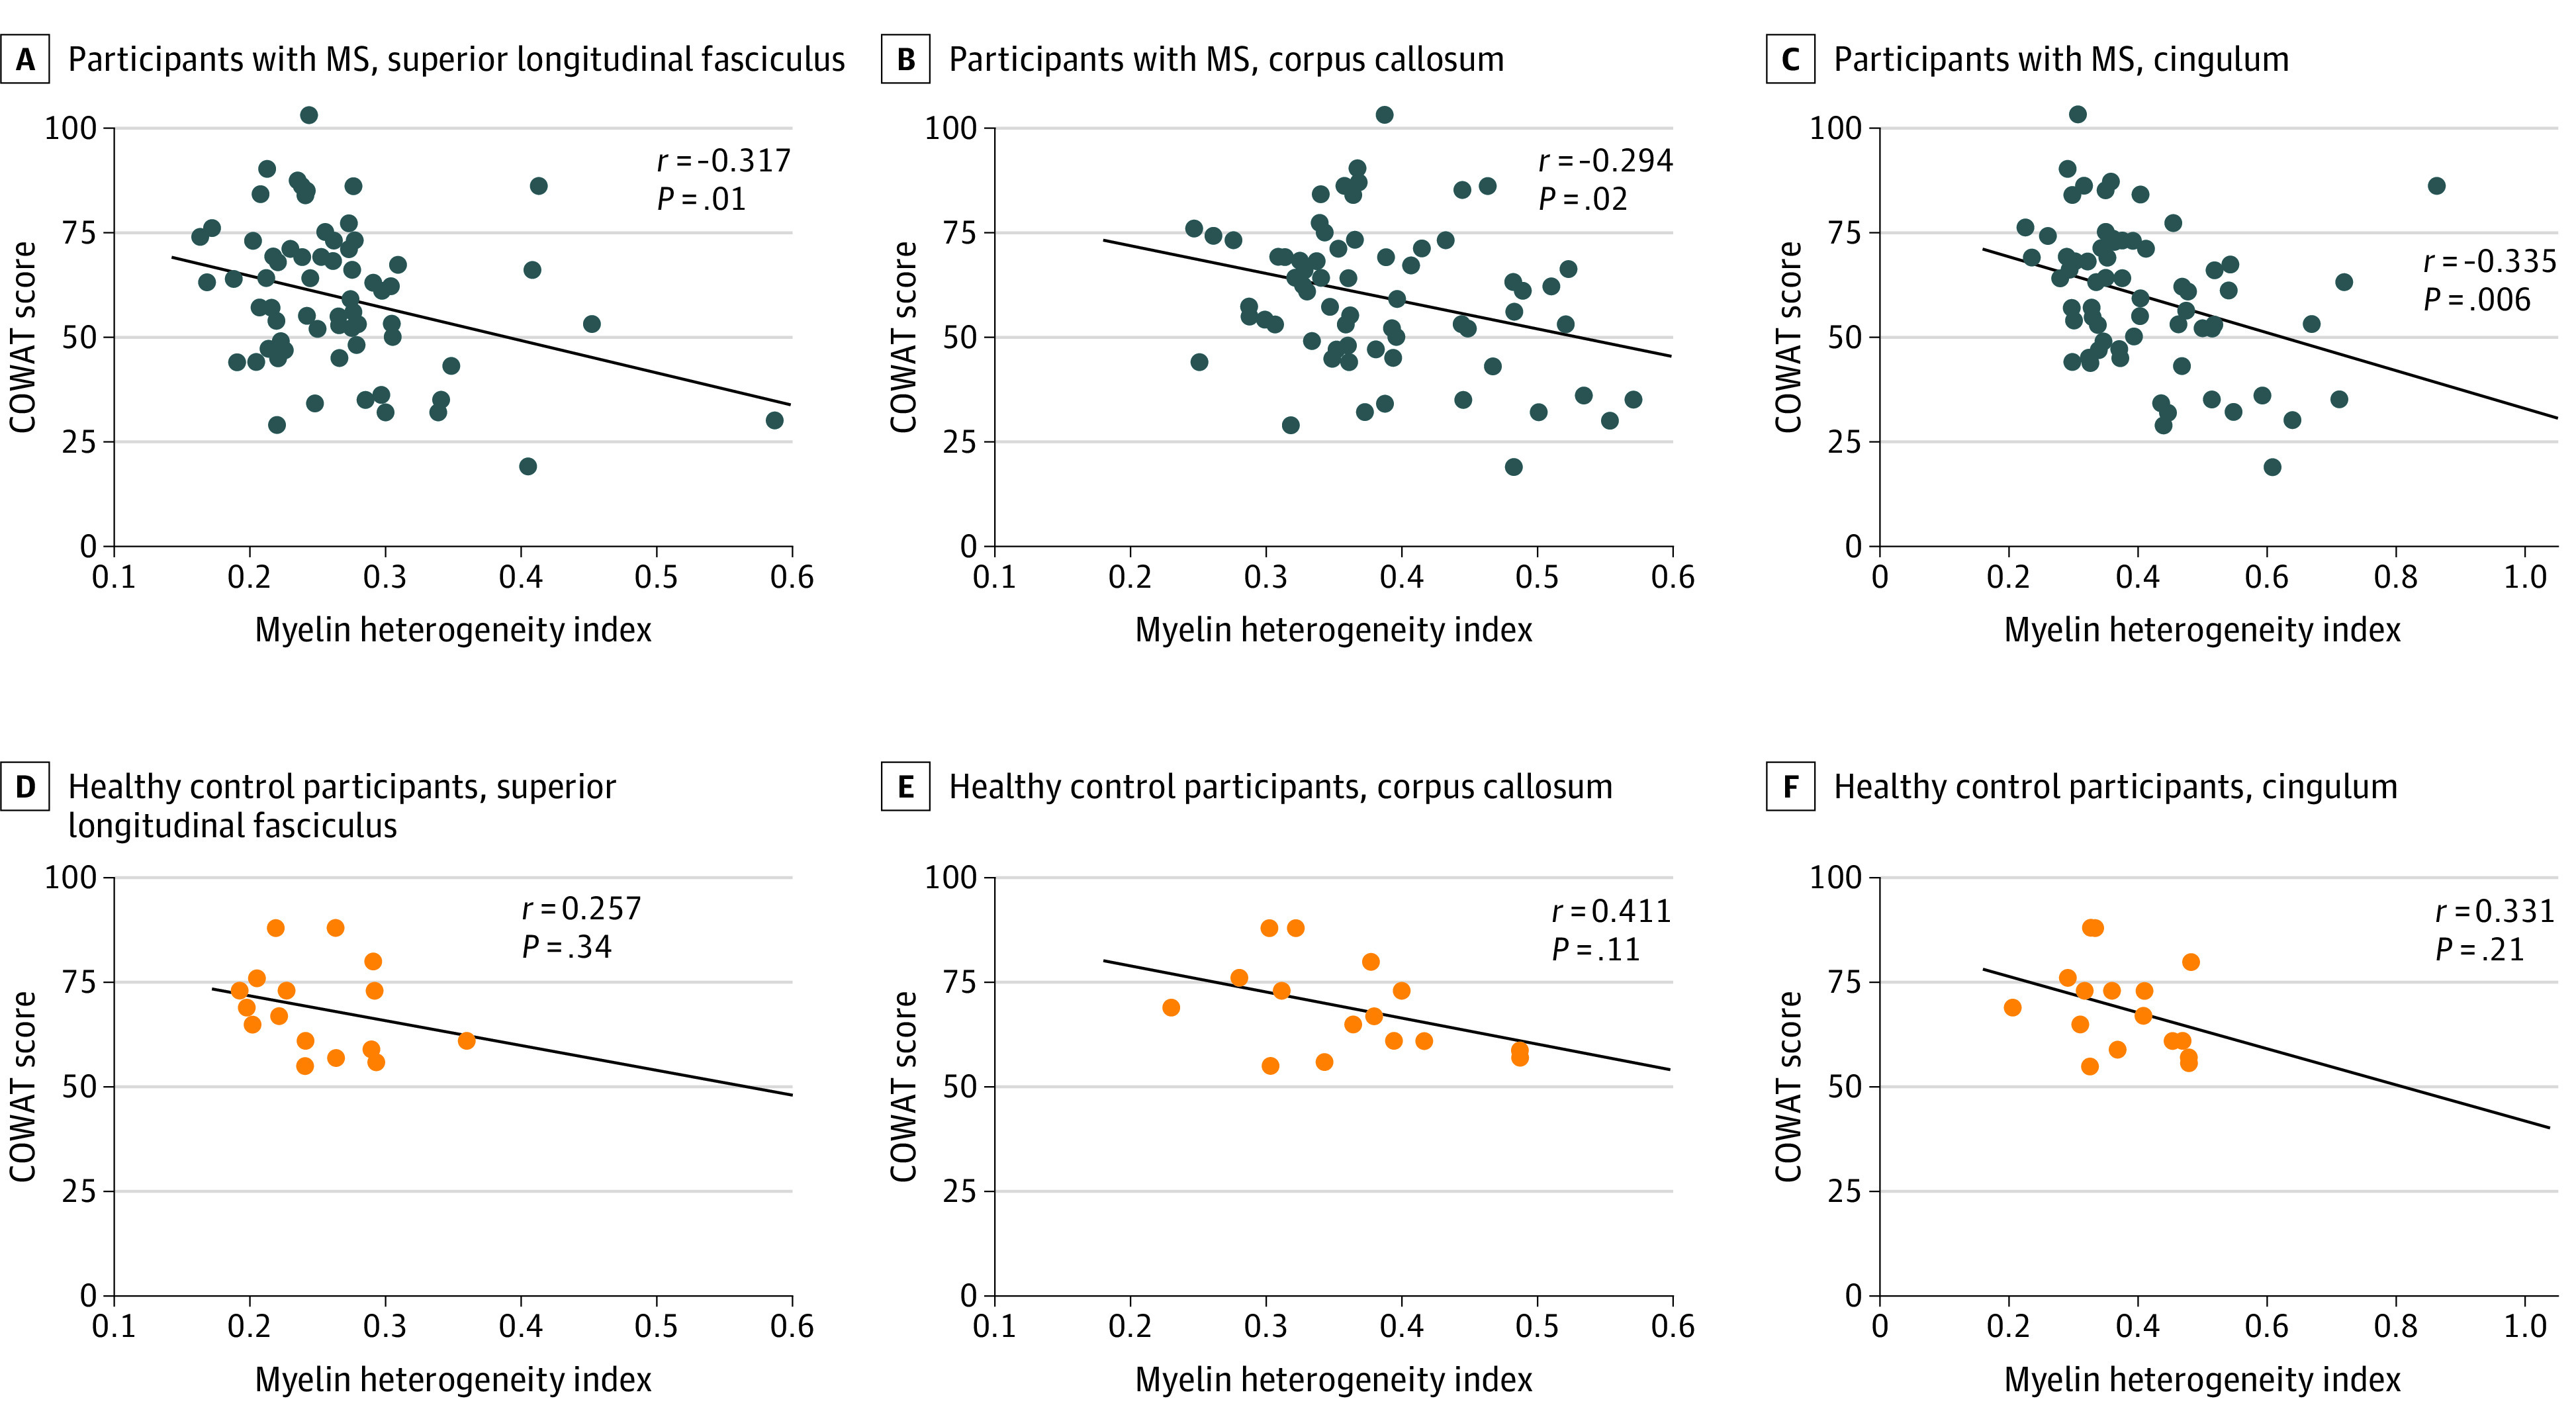
Correlations Between Controlled Oral Word Association Test (COWAT) Performance and Myelin Heterogeneity IndexCorrelations between the myelin heterogeneity index in normal-appearing white matter and COWAT scores are shown for participants with multiple sclerosis (MS) and controls in 3 regions of interest. Lines denote lines of best fit.